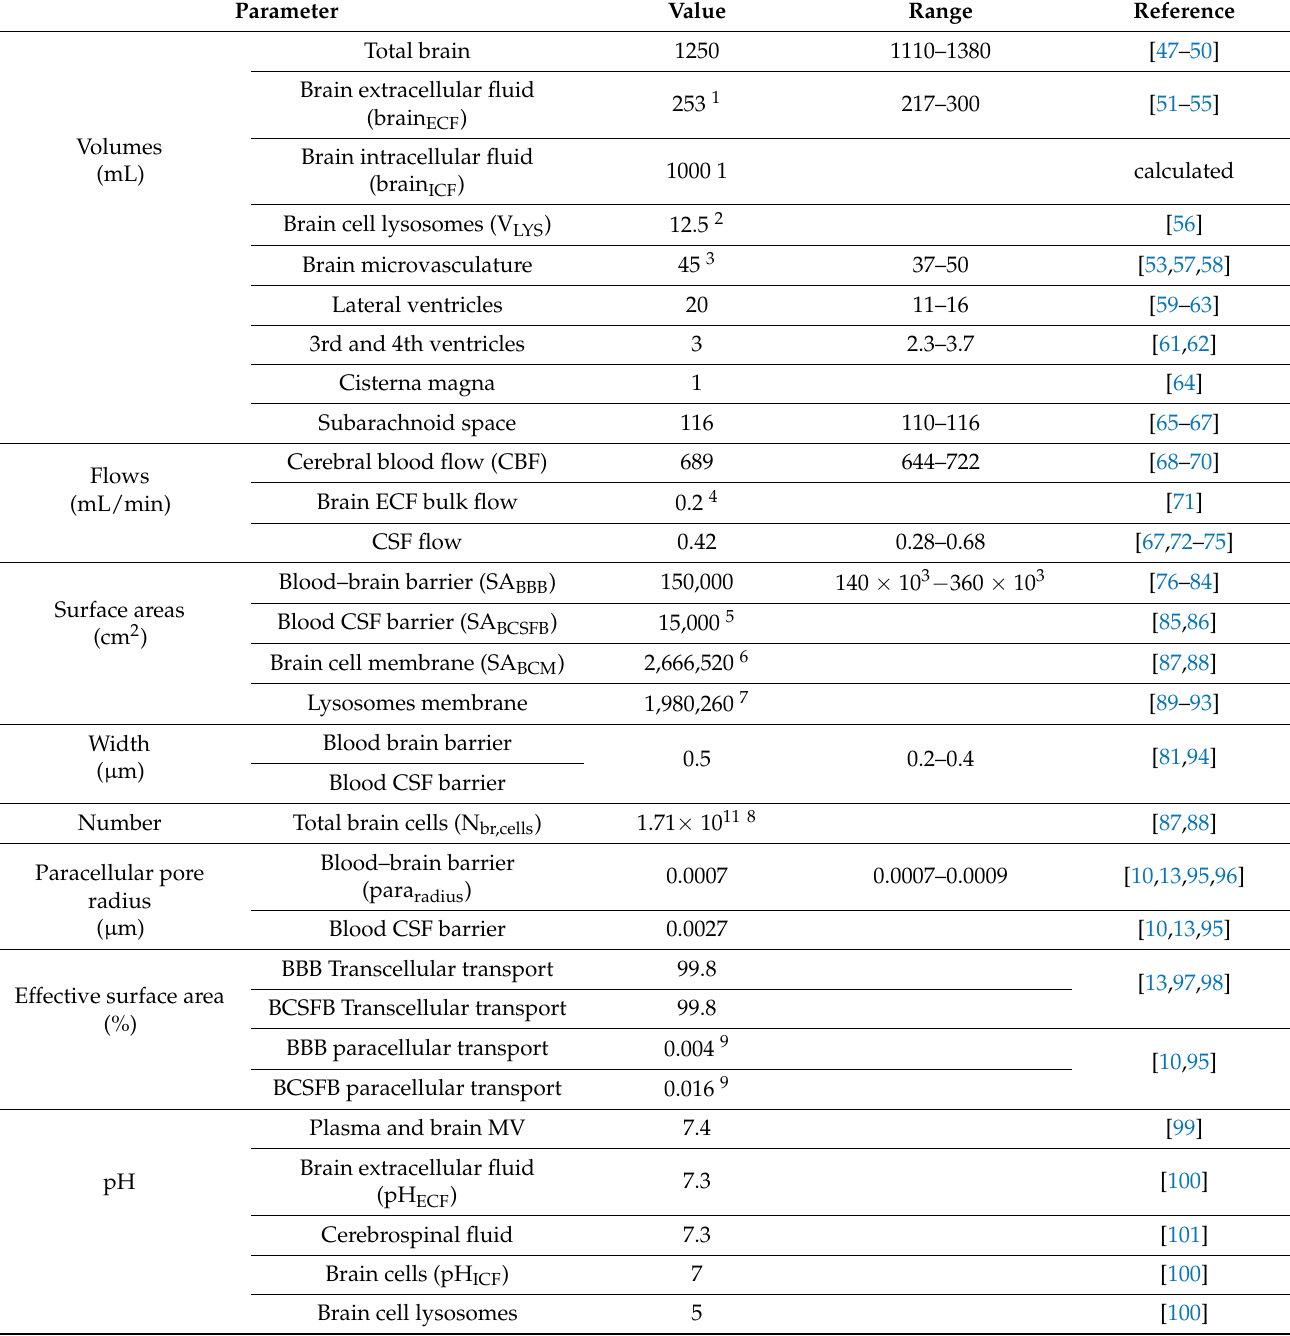
Table 1. Human CNS physiological parameters used in